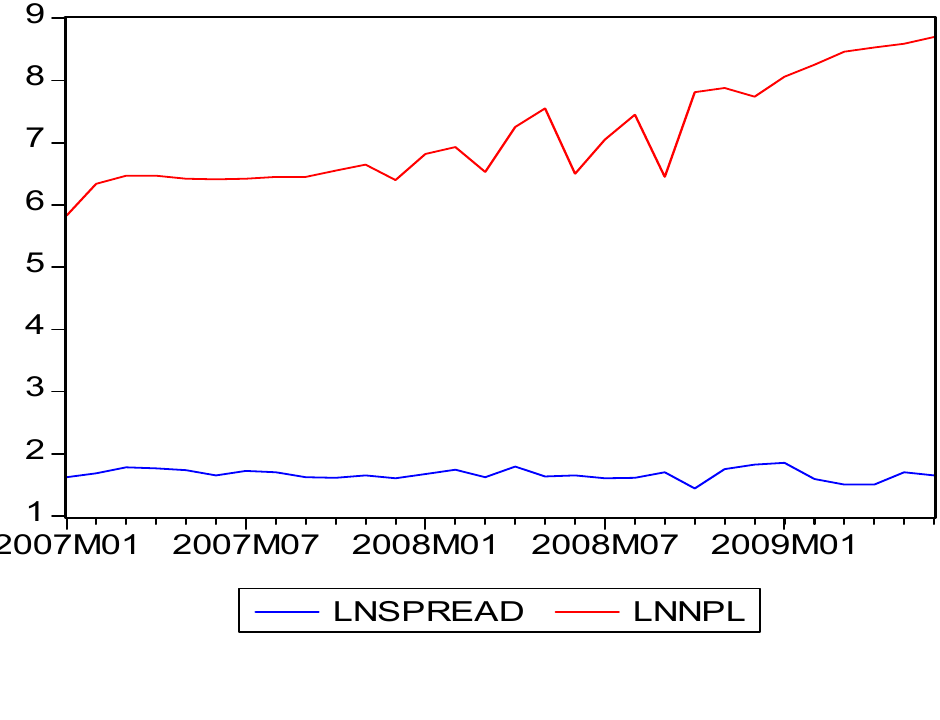
Figure-03: Non-Performing Financings and